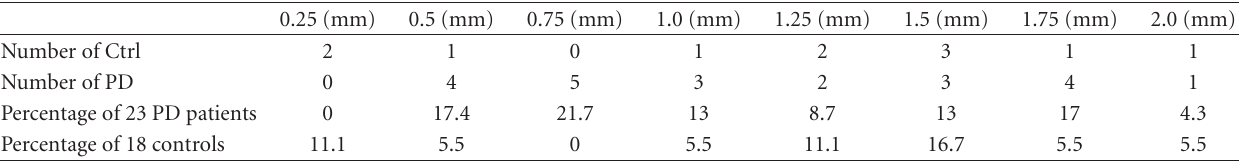
Table 2: Individual subjects outside their group’s retinal thickness mean IOD at 1 control SD at each radial distance (mm). It is evident that the most false positives (controls) were at 1 and 1.25 mm. The highest percentage of correctly identified patients was at 0.5 and 0.75 and to a lesser extent at 1mm and 1.75 perifoveolar distance (see also Table